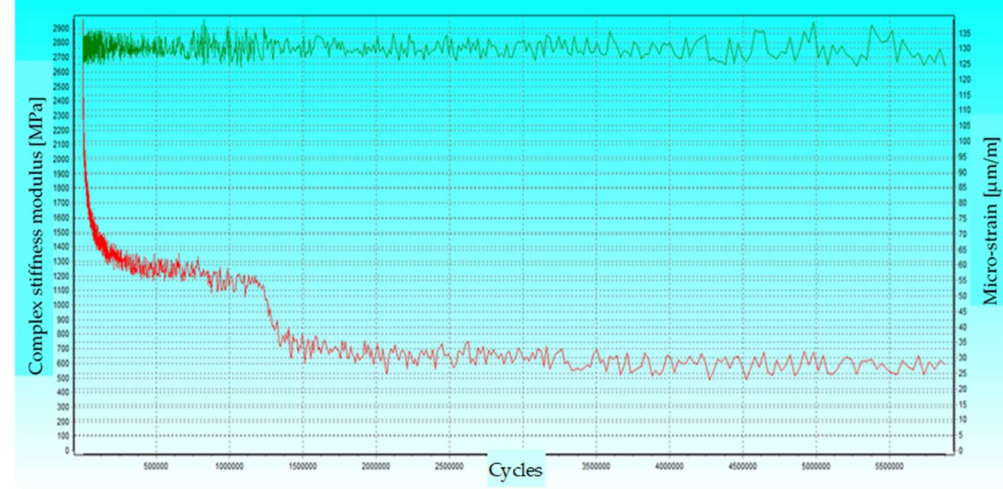
Figure 6. The course of the FAC mixture fatigue test at standard